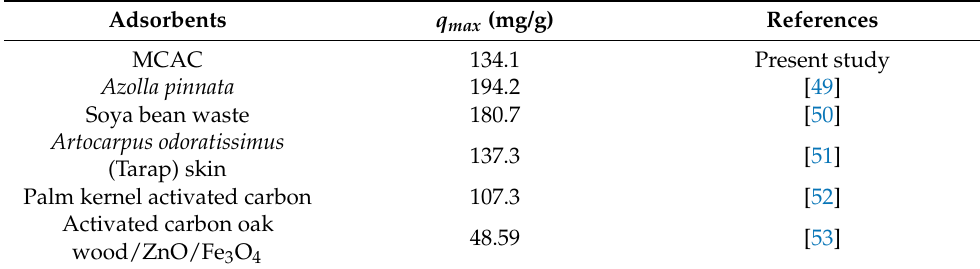
Table 9. A comparison of MV 2B adsorption capacities by various